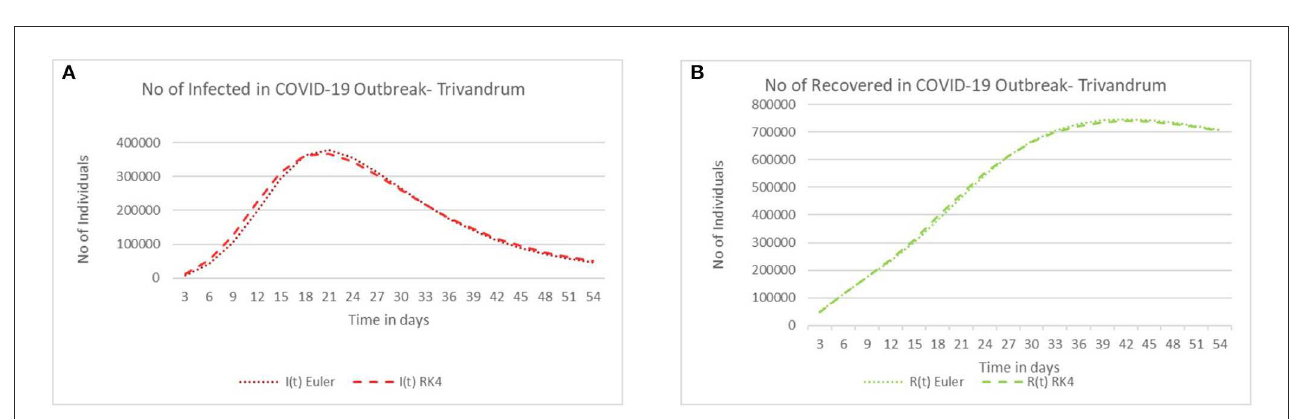
FIGURE4 (A) Comparison between Euler and fourth order Runge Kutta method in the case of infected. (B) Comparison between Euler and fourth order Runge Kutta method in the case recovered